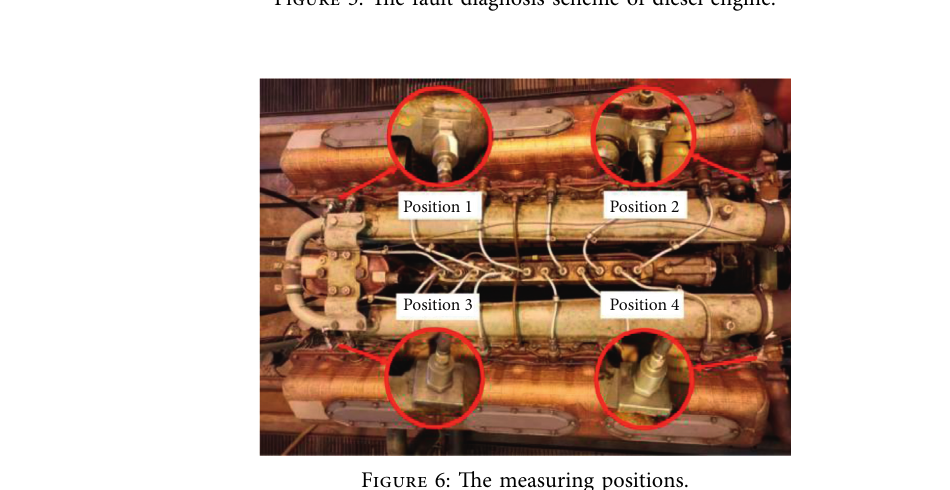
Figure 5: The fault diagnosis scheme of diesel engine.